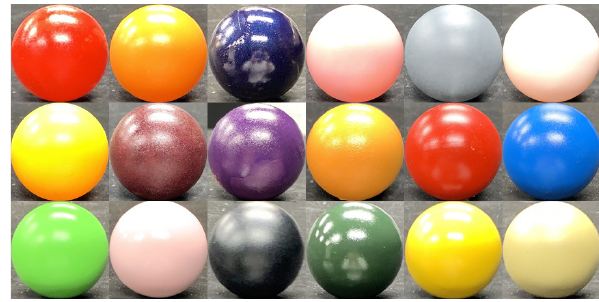
Figure 8. Reference objects.